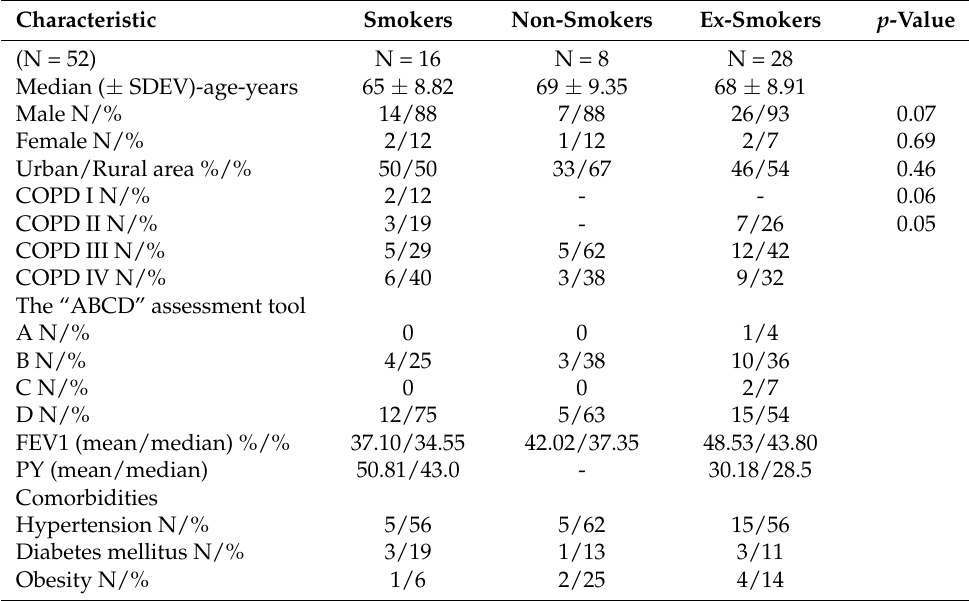
Table 1. Characteristics of the patients included in the